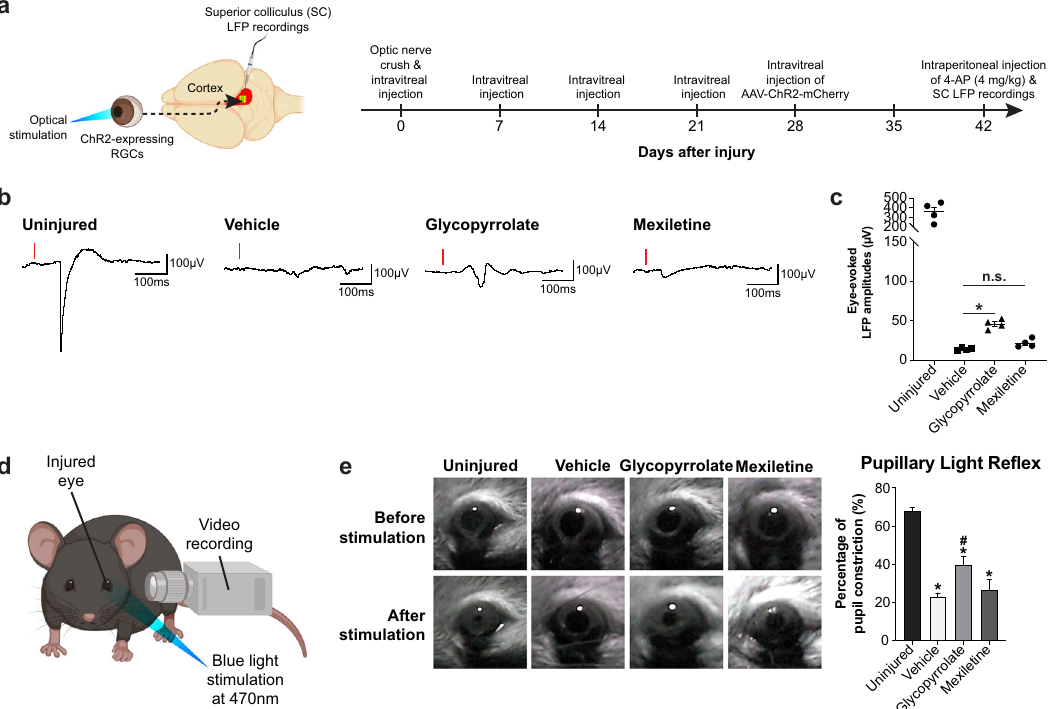
Fig. 9 Glycopyrrolate treatment elicits neural activity in target brain region and partially restores visual function. a Schematic diagram illustrating the glycopyrrolate or mexiletine treatment paradigm for optic nerve crush (ONC) and superior colliculus local fi eld potential (LFP) recordings upon optical stimulation of retinal ganglion cells (RGCs). b Representative eye-evoked LFPs from all treatment groups. Red lines indicate the onset of optogenetic stimulation. c We detected minimal eye-evoked LFP from mexiletine-treated mice, as re fl ected by limited number of regenerating axons in the optic chiasm. In stark contrast, glycopyrrolate treatment markedly increased the maximal eye-evoked LFP by 3.2-fold, when compared with vehicle-treated mice. d Schematic diagram illustrating the pupillary light re fl ex (PLR) test. Mice were allowed to adapt to dark conditions for 1 h before the PLR test. The relative pupil constriction in percentage was calculated as the percentage change in pupil area between the baseline reading after 1-h dark adaptation and 30 s after the light stimulus at 470 nm. e Glycopyrrolate treatment partially restored the pupil constriction, while vehicle-treated control mice failed to fully constrict the pupil upon light stimulation at 6 weeks after ONC. Pupillary diameters were comparable in the mexiletine-treated and vehicle-treated mice. Mean ± SEM ( n = 4 per group in ( c ), n = 4 – 6 per group in ( e )). * P < 0.05 compared with uninjured eye, # P < 0.05 compared with vehicle-treated controls; one- way ANOVA followed by post hoc Bonferroni test. n.s. not signi fi